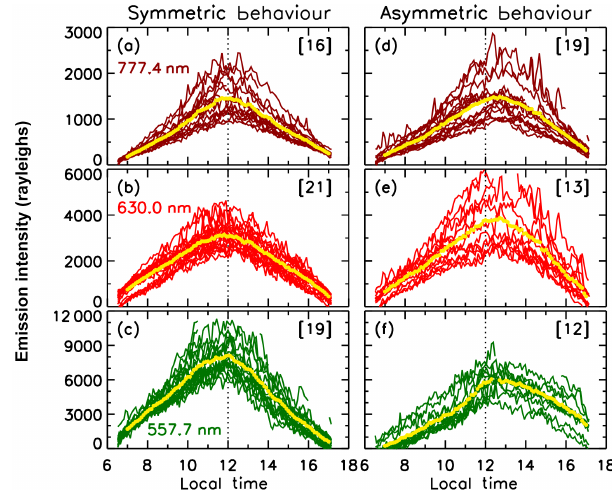
Figure 3. The diurnal behaviour in optical dayglow emission in- tensities at (a, d) OI 777.4nm, (b, e) OI 630.0nm, and (c, f) OI 557.7nm is shown. The plots in the left column (a, b, c) show the plots with symmetric diurnal behaviour in intensities with respect to local noon. Plots (d, e, f) show asymmetric diurnal behaviour in intensities with respect to local noon. The yellow line shows the av- erage of all the days of the data. The number of days of data that exist for a given diurnal behaviour is shown in square